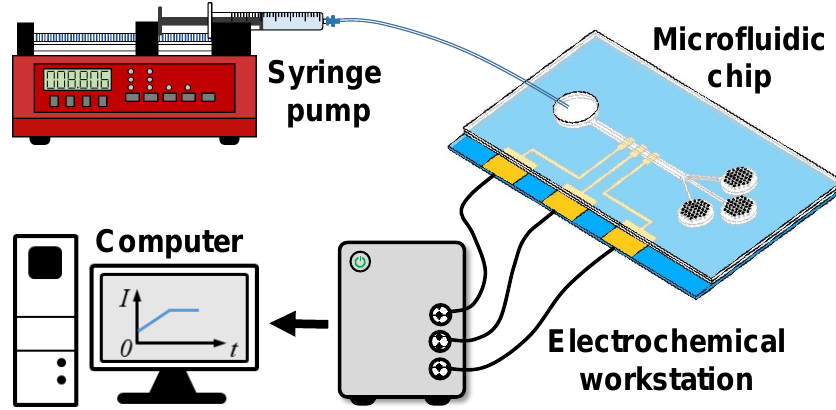
Figure 3. Schematic diagram of the experimental system.